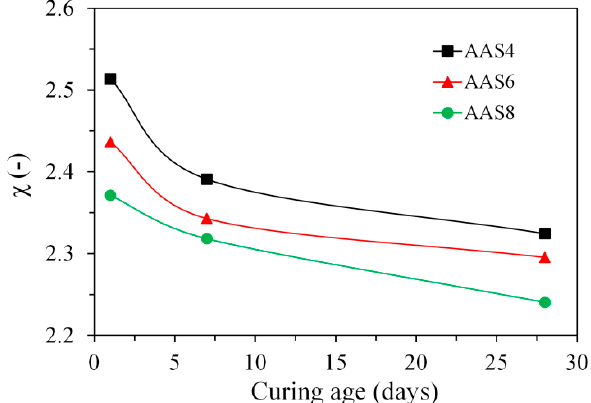
Figure 16. The volume ratio ( χ , V products /V slag-reacted ) of the reaction products relative to the reacted slag for the samples of AAS4, AAS6, and AAS8 at 1, 7, and 28 days. In the graph, AAS indicates alkali-activated slag, and the number following AAS refers to the weight percentage of Na 2 O with respect to slag. For all samples, the water to slag ratio was 0.4 and the curing temperature was 20 °C. The volume ratio ( χ ) decreases with curing age for all the sodium hydroxide activated samples.